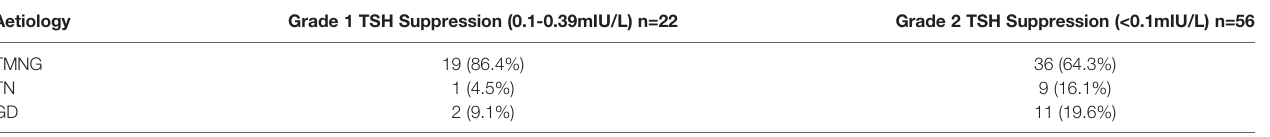
TABLE 3 | Severity of TSH Suppression, classi fi ed by SCT aetiology. Aetiology